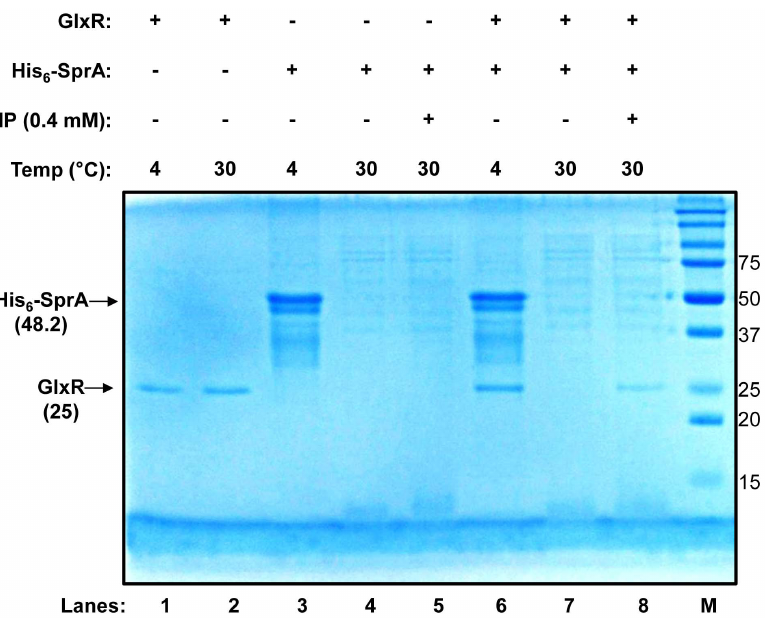
Figure 7. Effects of cAMP on invitro digestion of GlxR by His 6 -SprA. Protein purification and proteolytic assays were performed as described in the Materials and Methods. Proteins were incubated at 4 u C or 30 u C for 20 h, analyzed on a 15% SDS-PAGE gel, and then visualized by staining with Coomassie brilliant blue G250. Molecular weights are shown in kDa. M, molecular weight markers; and MBP, maltose-binding protein.